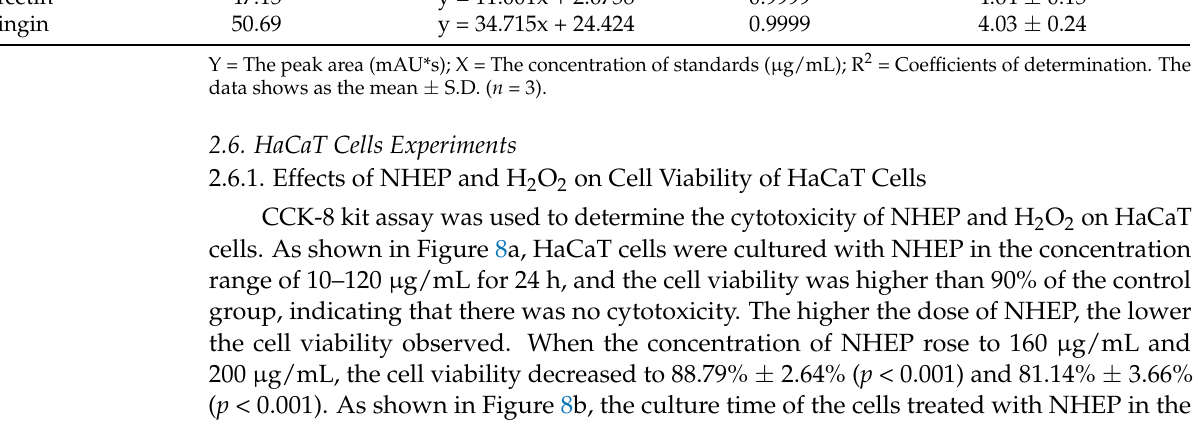
Figure 7. HPLC of mixed standards ( a ) and NHEP ( b ). 1-gallic acid, 2-corilagin, 3-ellagic acid, 4-rutin, 5-myricetin, 6-quercetin, 7-naringin. Table 4. Polyphenols and flavonoids compositions of NHEP by the characterization of HPLC. Standard Retention Time (min) Regression Equation